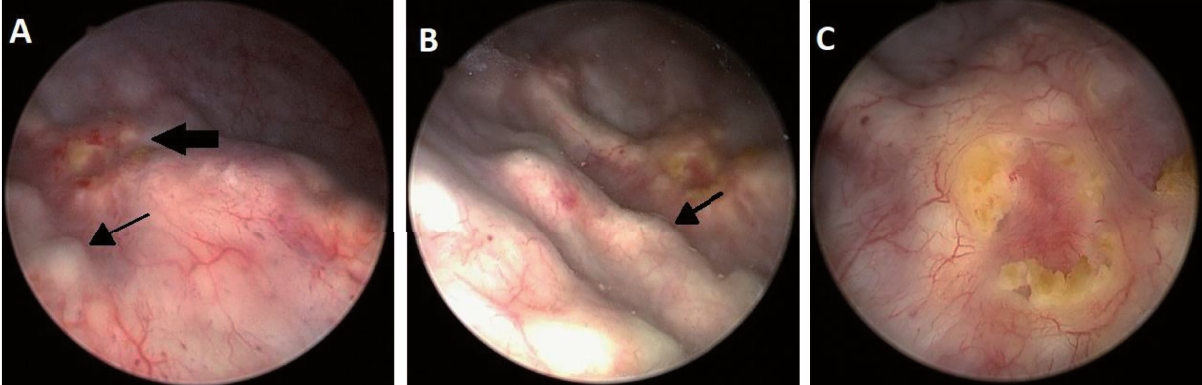
with intact mucosa (narrow arrow); B) Image focused on elevated lesions (thick arrow); C) image focused on ulcerated